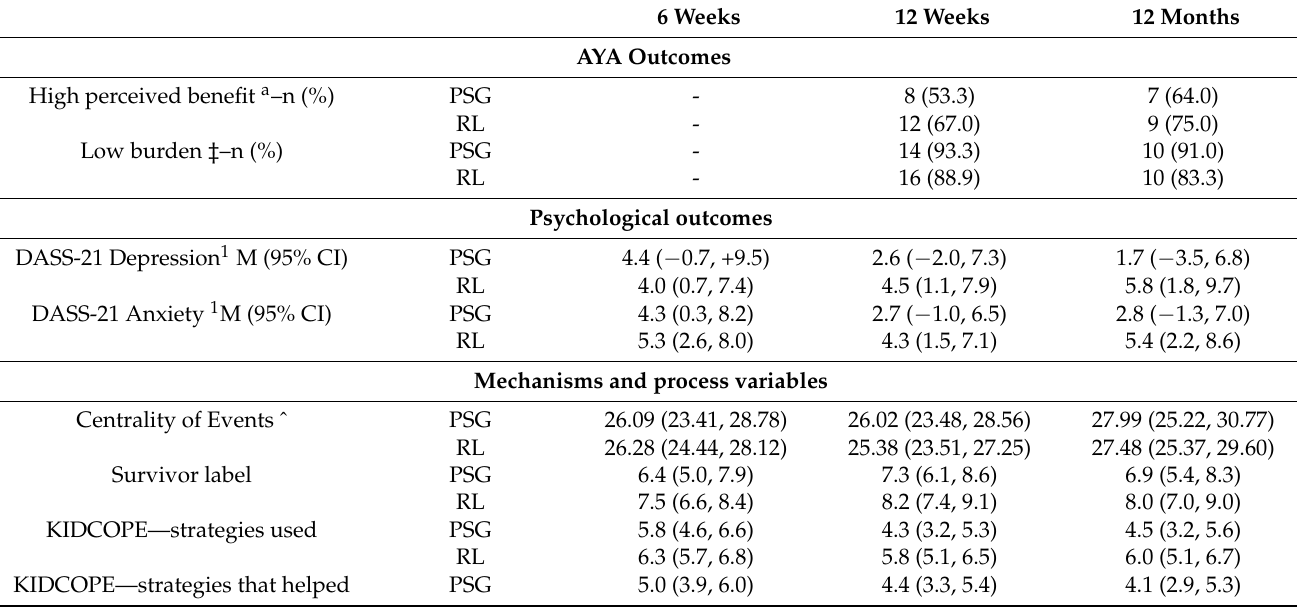
Figure 2. Differences between Recapture Life and peer-support group on negative impact of cancer, over time. Note. Individual scores are displayed, overlaid with thicker lines showing group-specific means and 95% confidence intervals. Three-way analyses comparing Recapture Life, peer-support group and waitlist are depicted in Supplementary Data S4). Table 4. Outcome measures * by intervention arm across